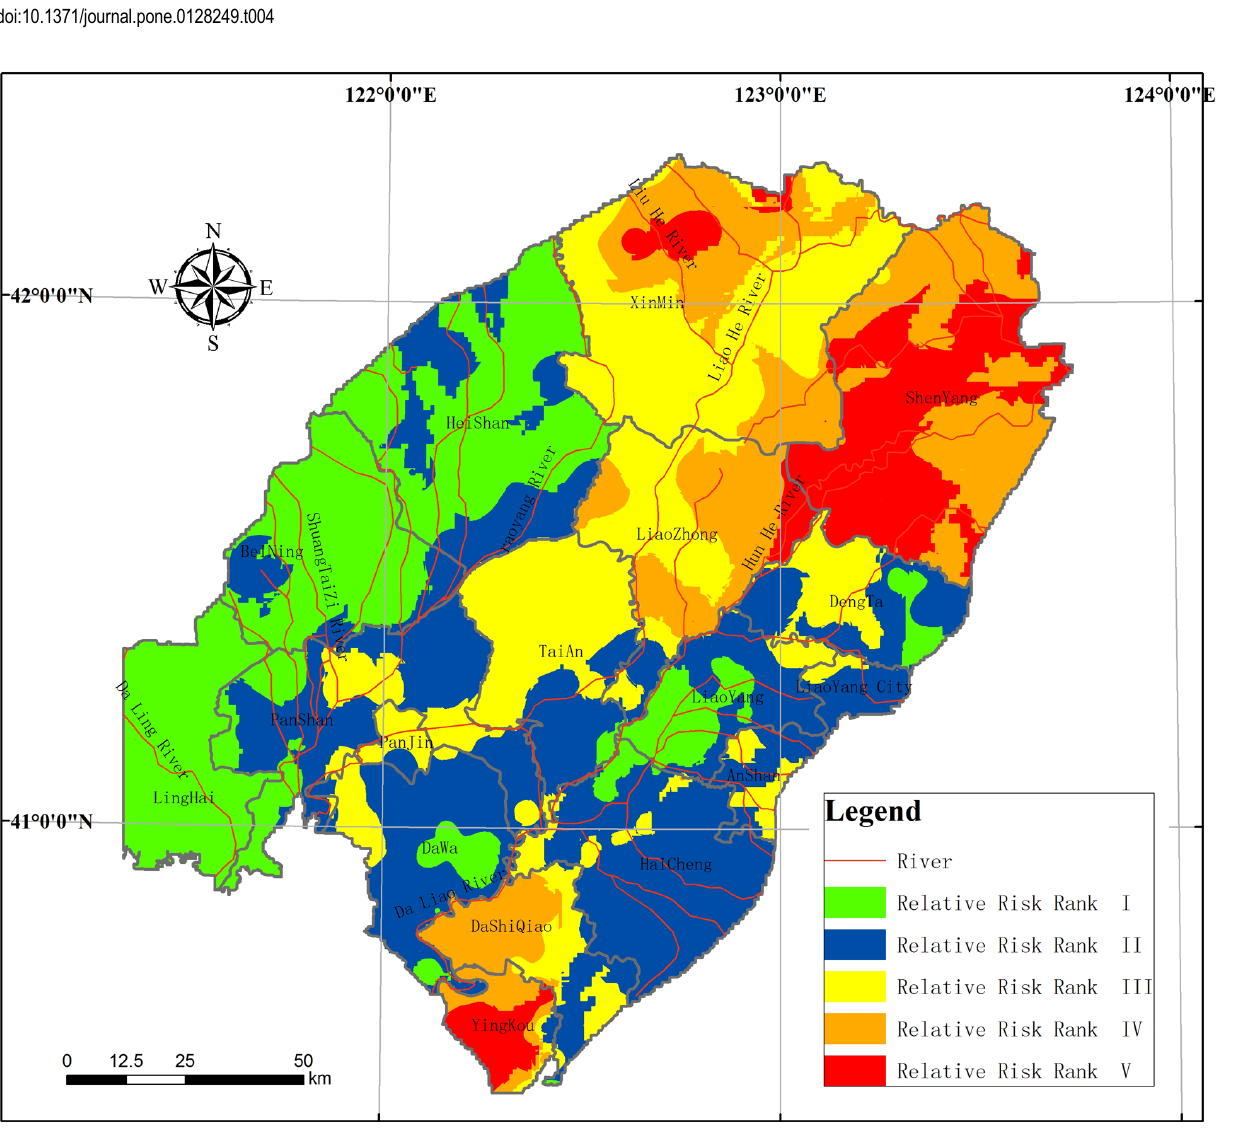
Fig 9. Regional Groundwater Environment Risk assessment RRR in the study area.